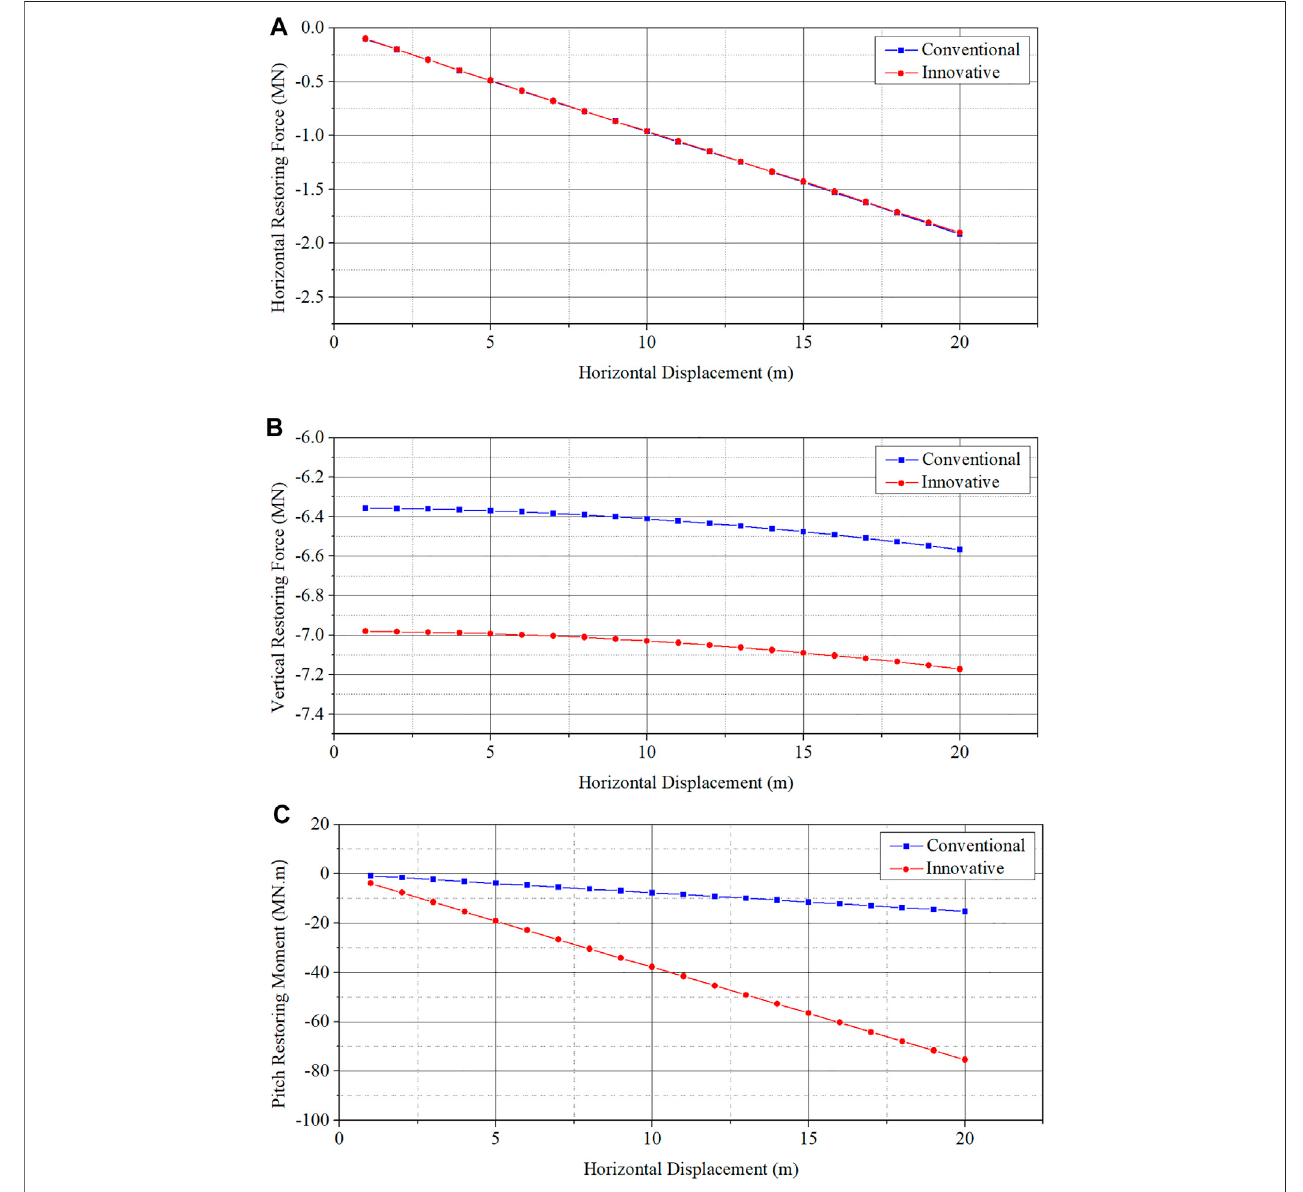
FIGURE 5 | Static restoring force and moment. (A) Horizontal restoring force. (B) Vertical restoring force. (C) Pitch restoring